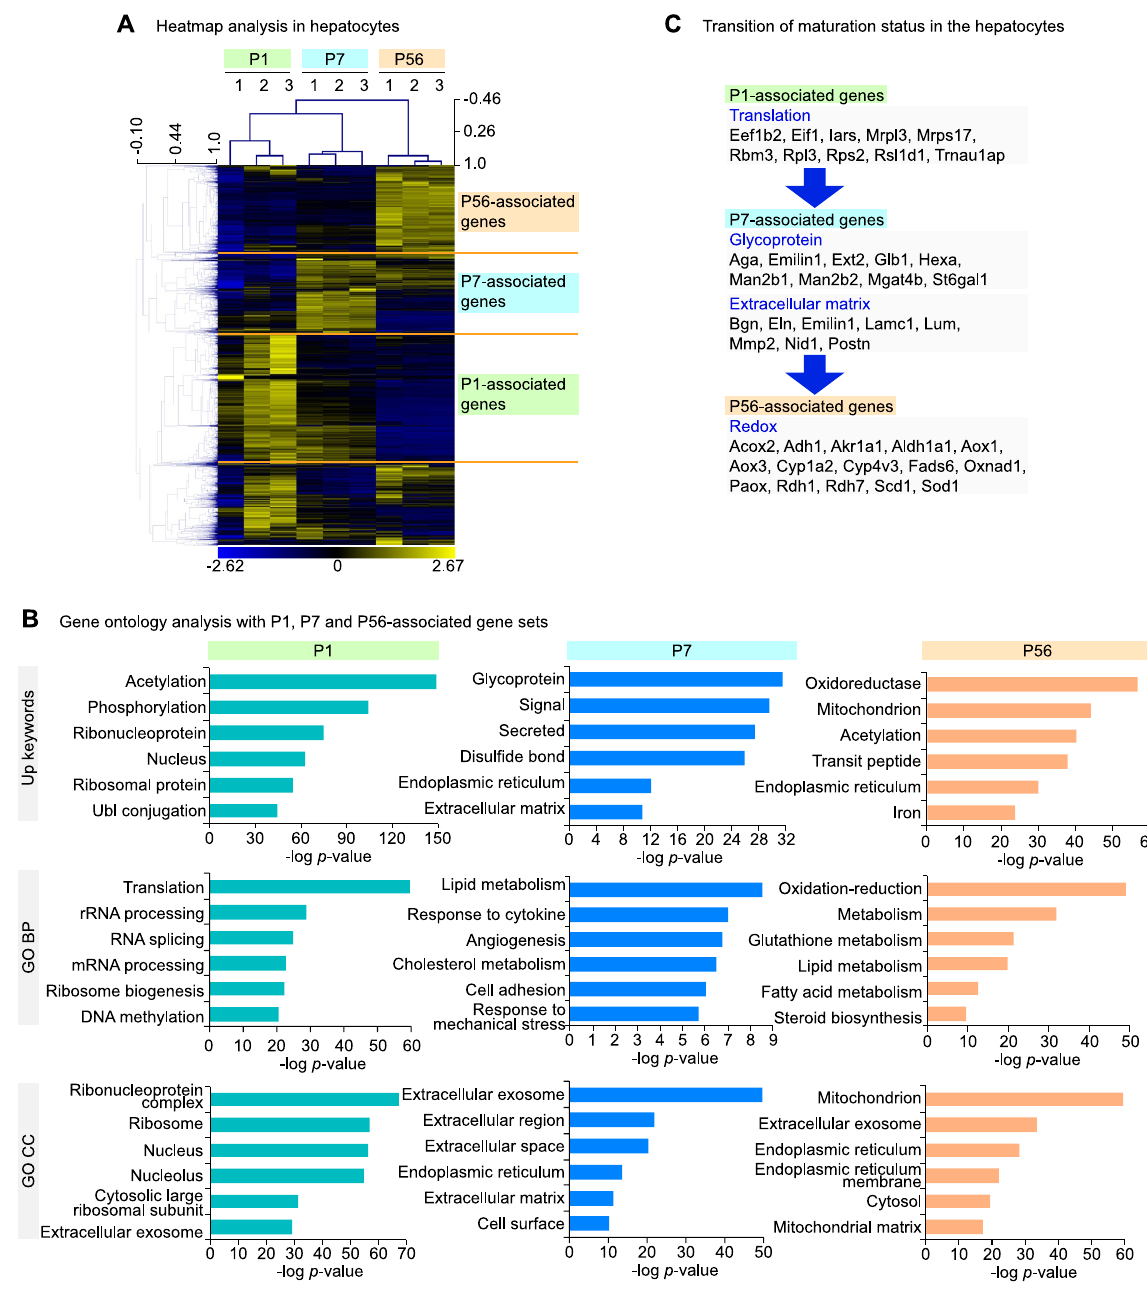
Figure 3. Maturation dynamics in the hepatocytes. ( A ) Heatmap analysis of transcriptome analysis in the hepatocytes at different ages. The distinct sets of genes were present as noted as P1-, P7- and P56-associated genes. ( B ) The GO analysis describing the transition of cellular functions in the hepatocytes. GO BP, gene ontology biological process. ( C ) A schematic for the transition of the cellular functions in the postnatal